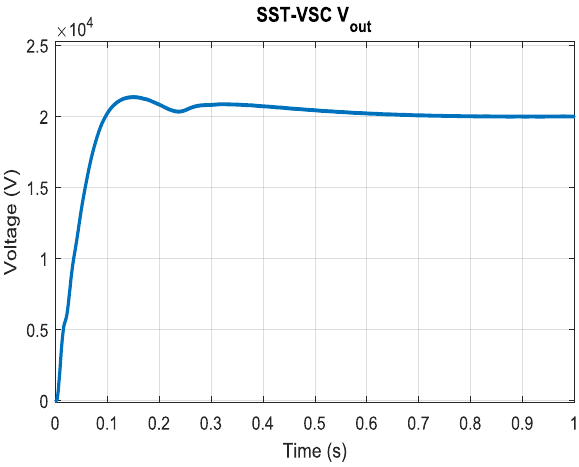
Figure 24. SST-VSC response working as the PFI device with induction motor loading.